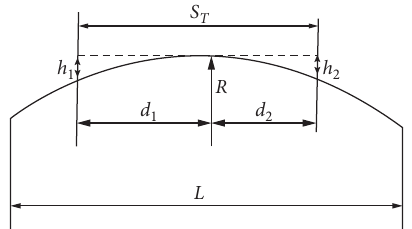
Figure 5: Calculation scheme of a convex vertical curve ( L ＜ S